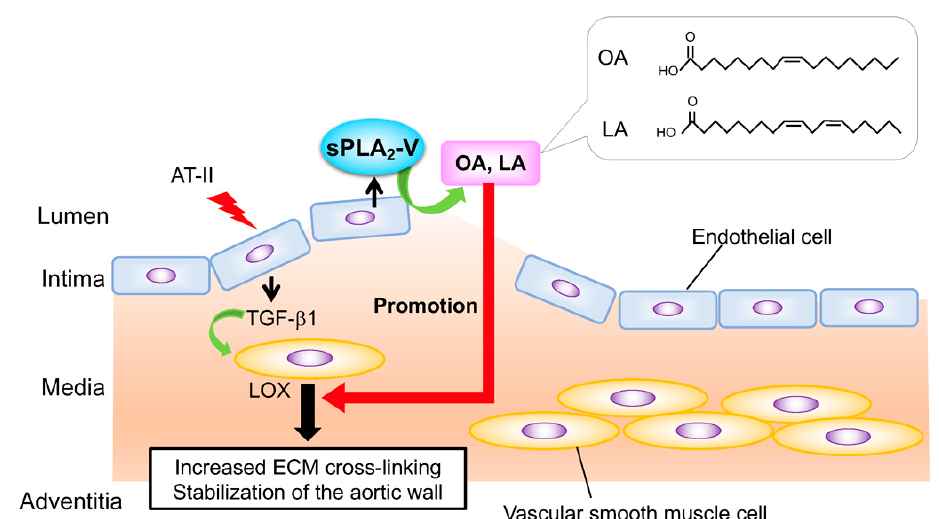
Figure 3. The role of endothelial sPLA 2 -V in aortic stability. sPLA 2 -V is a major sPLA 2 isoform expressed in aortic endothelial cells (ECs) and is largely retained on the luminal surface of the aortic endothelium likely through binding to heparin sulfate proteoglycans. Endothelial sPLA 2 -V acts on membrane phospholipids of AT-II-activated ECs to mobilize oleic acid (OA) and linoleic acid (LA), which in turn promote AT-II-induced upregulation of lysyl oxidase (LOX) that facilitates ECM crosslinking, thereby stabilizing the aortic wall. Impairment of this sPLA 2 -V-driven lipid pathway leads to increased susceptibility to aortic dissection.